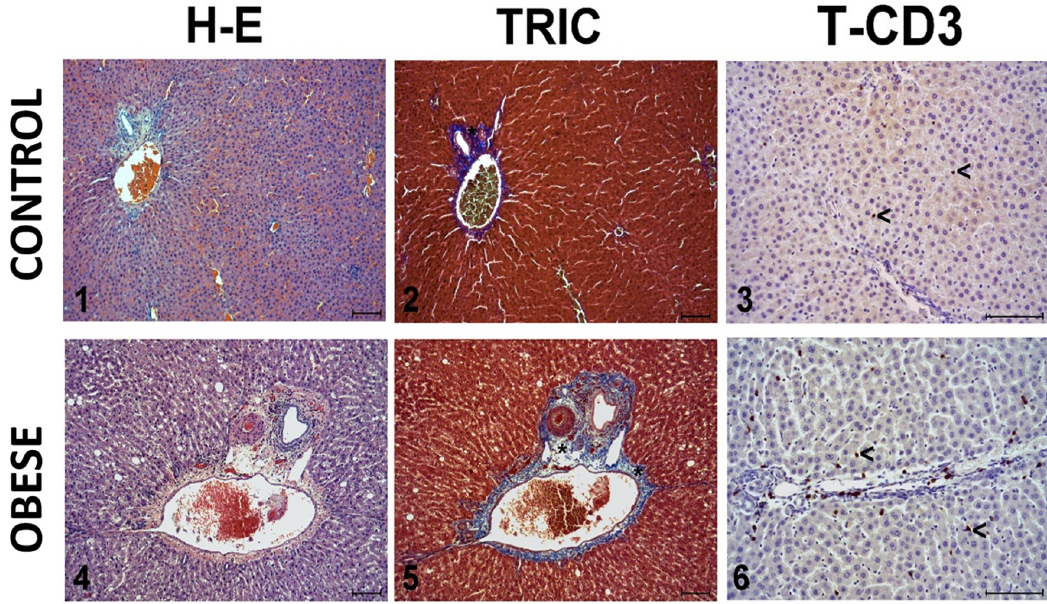
Fig 5. Representative images of the liver histopathology examination (1 & 4), surface area of fibrosis (2 & 5, asterisks), and CD3 T lymphocyte infiltration (3 & 6, arrowheads) in the control group (1–3) and obese group (4–6). Haematoxylin-eosin technique (HE) (1 & 4), Masson’s trichrome staining (TRIC) (2 & 5) and ABC anti-CD3 T lymphocytes (T-CD3) (3 & 6). Scale: 100